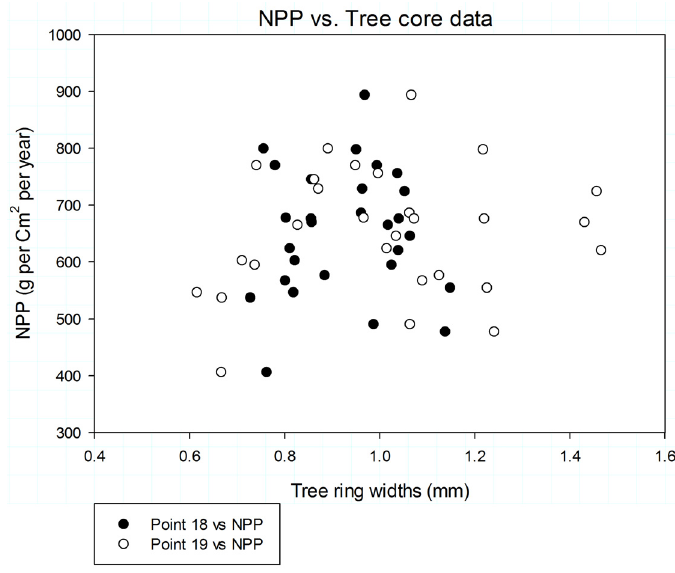
Figure 8. Plot of NPP versus tree